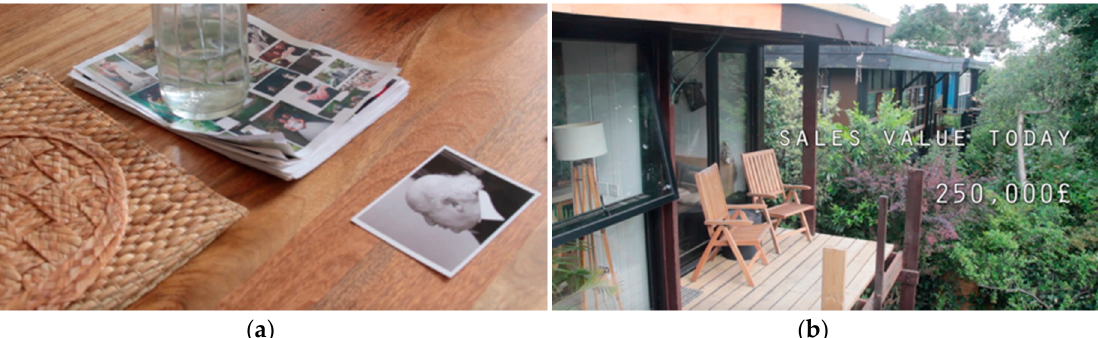
Figure 3. Vanessa Koepper: Social Housing in London: Walter Segal´s self-build houses: ( a ) Scene of the book sale; ( b ) Final scene on one of the